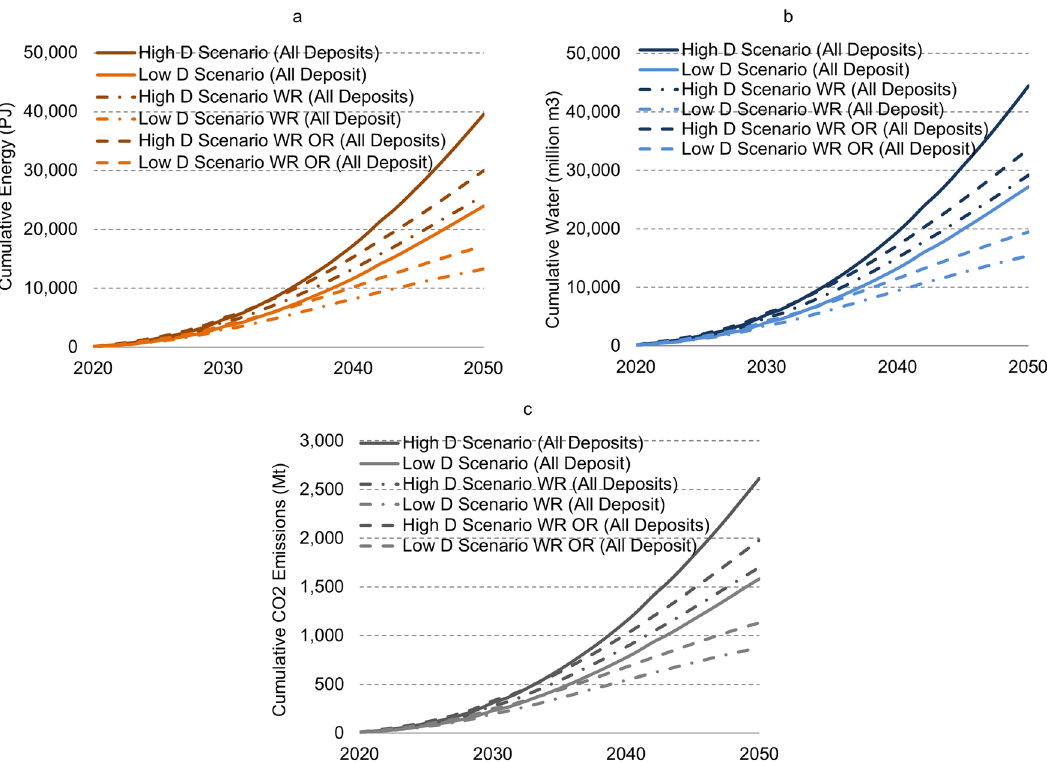
Fig. 7 Energy, water, and CO 2 emissions associated with oversupplied REEs in two demand scenarios and two secondary supply scenarios. Cumulative a energy, b water, and c CO 2 emissions associated with the oversupplied REEs in the two demand scenarios and the two secondary supply scenarios; High D Scenario (All deposits) combines the high demand scenario, no recycling, and supply from all deposits; Low D Scenario (All deposits) combines the low demand scenario, no recycling, and supply from all deposits; High D Scenario WR (All deposits) combines the high demand scenario, Dy recycling, and supply from all deposits; Low D WR Scenario (All deposits) combines the low demand scenario, Dy recycling, and supply from all deposits; High D Scenario WR OR (All deposits) combines the high demand scenario, Dy and other REEs recycling, and supply from all deposits; Low D WR Scenario (All deposits) combines the low demand scenario, Dy and other REEs recycling, and supply from all